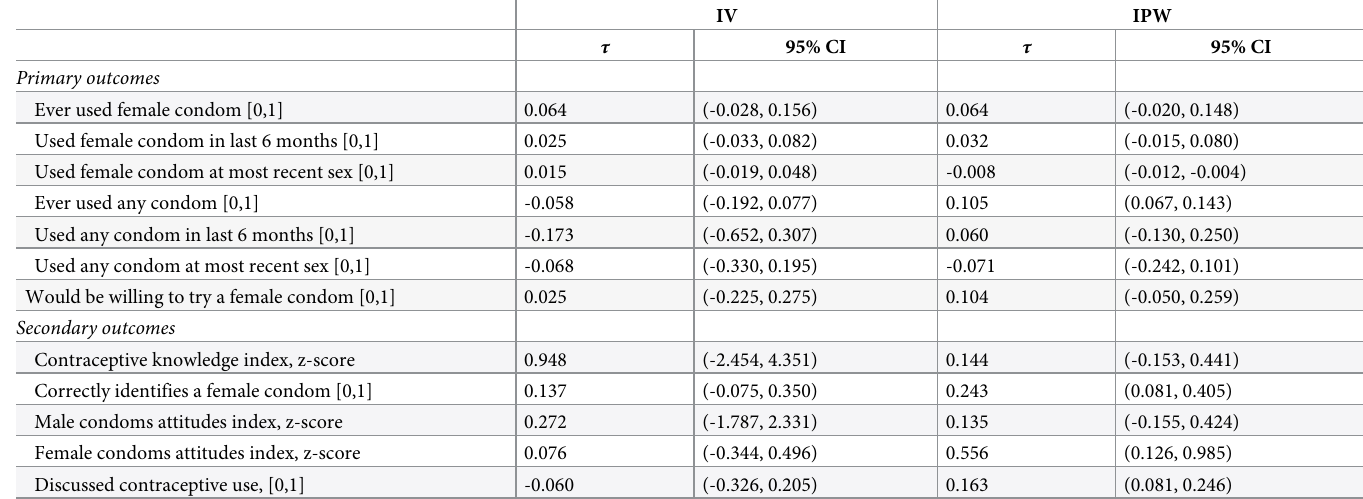
Table 4. Instrumental variable and inverse probability weighting analyses to assess compliance effects of attending the IPC